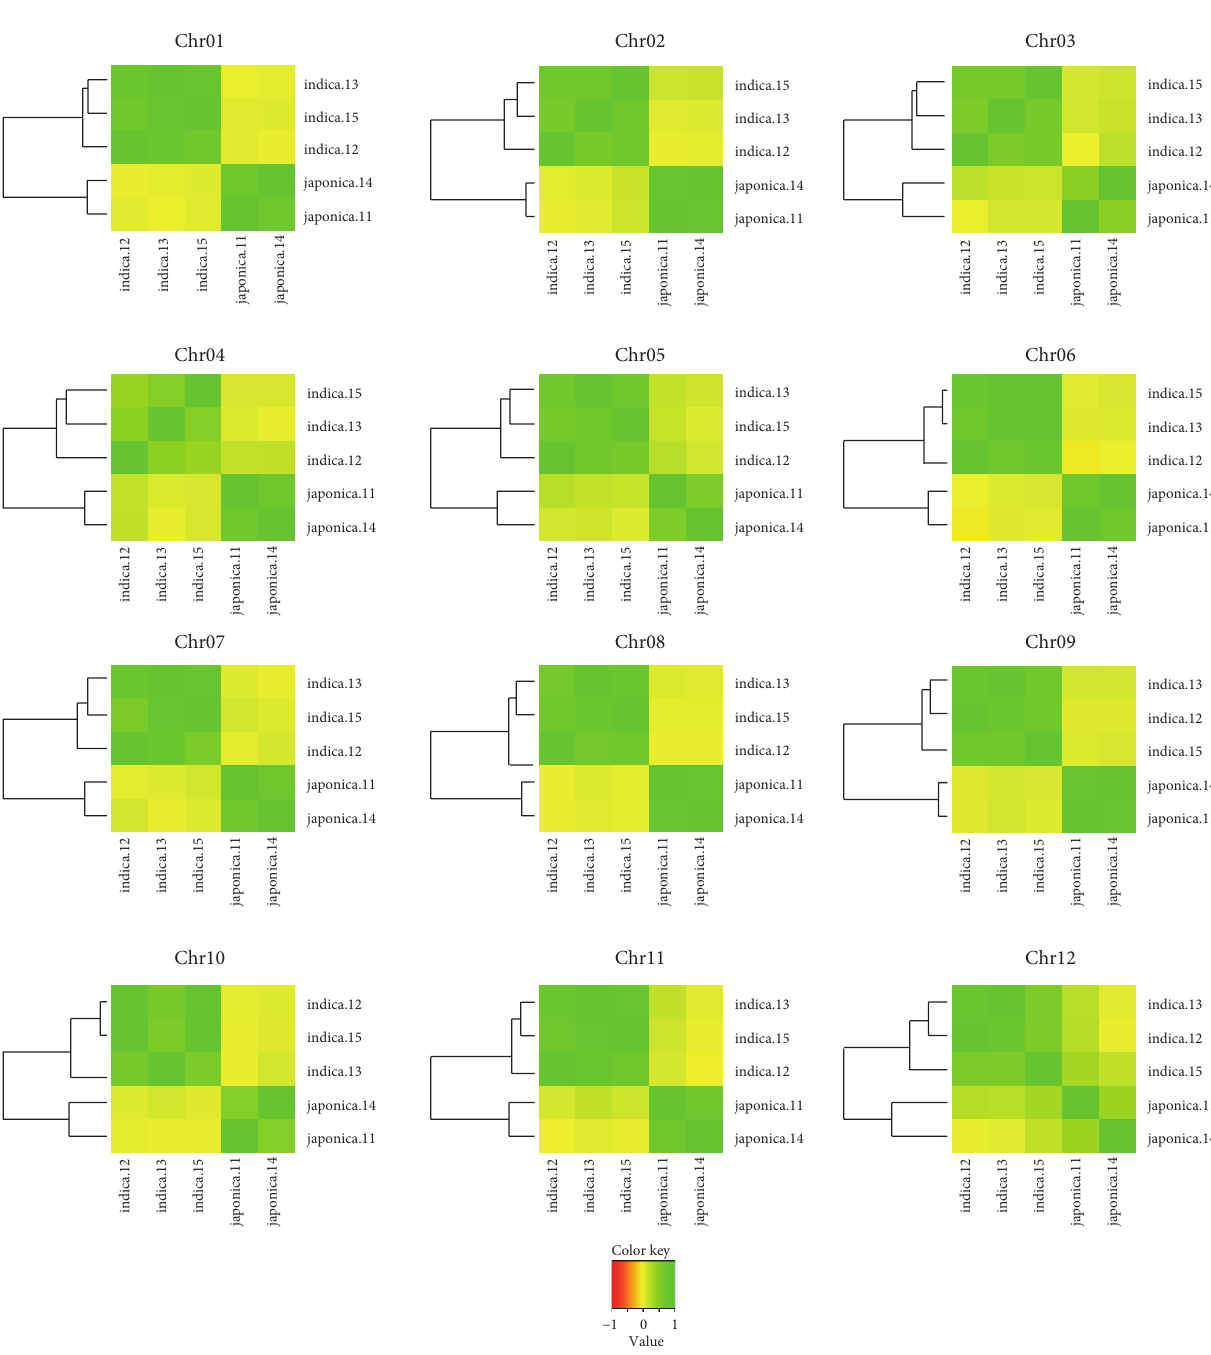
Figure 4: The heatmap and cluster view showing the correlation among the five landraces on the 12 chromosomes. Pearson correlation coefficients were calculated based on the SNP densities per 100kb on the